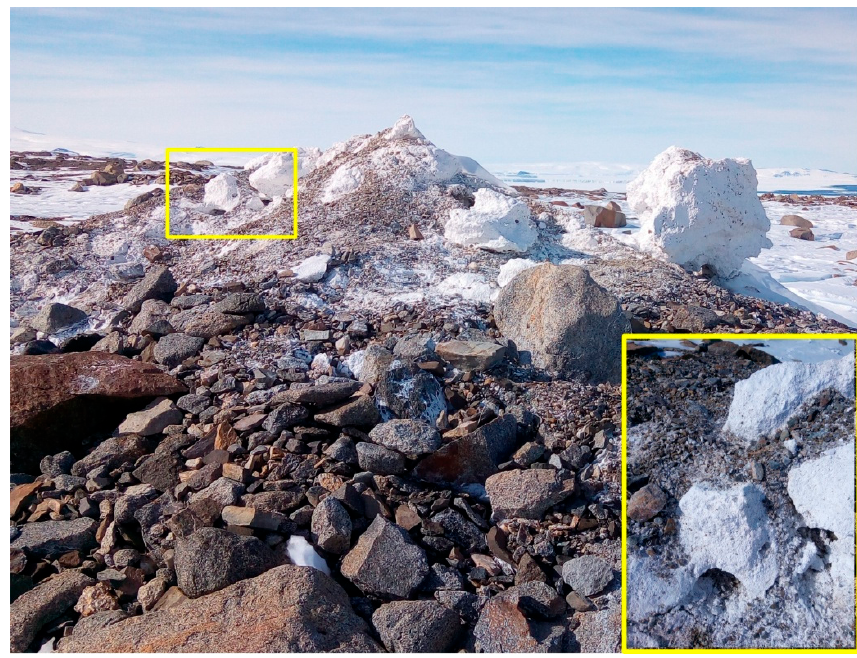
Figure 3. Rock-salt extrusions on the Boulder Clay Moraine surface.